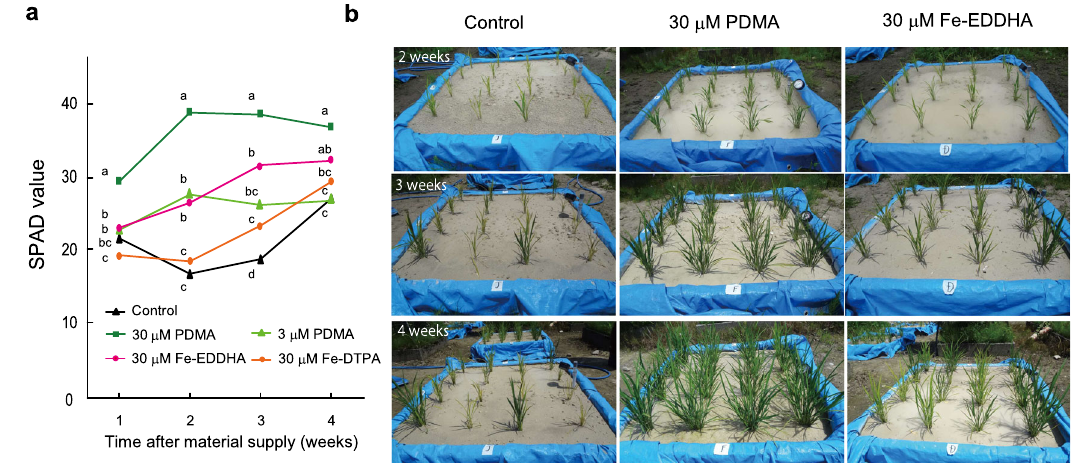
Fig. 8 Pilot fi eld experiment showing the effects of chelates on rice growth in calcareous soil. a SPAD values of the newest leaves from 1 to 4 weeks after chelate application, showing the superiority of 30 µ M unchelated PDMA and 30 µ M Fe-ethylenediamine di(o-hydroxyphenylacetic) acid (EDDHA) in overcoming Fe de fi ciency. Values are the mean of three replicates in which each replicates is control, 48 (Contol), 32 (30 µ M PDMA, 3 µ M PDMA, 30 µ M Fe-EDDHA), and 16 (30 µ M Fe-DTPA). Different letters indicate signi fi cant differences at P <0.05 by Tukey ’ s honestly signi fi cant difference test (two-sided). P -values for one-way analysis of variance (ANOVA) are follows: 1 week <0.0001, 2 weeks <0.0001, 3 weeks <0.0001, 4 weeks <0.0001. b Photographs of rice plants at 2 – 4 weeks after treatment. PDMA proline-2 ′ -deoxymugineic acid, EDDHA ethylenediamine- N , N ’ -bis(2-hydroxyphenylacetic acid), DTPA diethylenetriaminepentaacetic